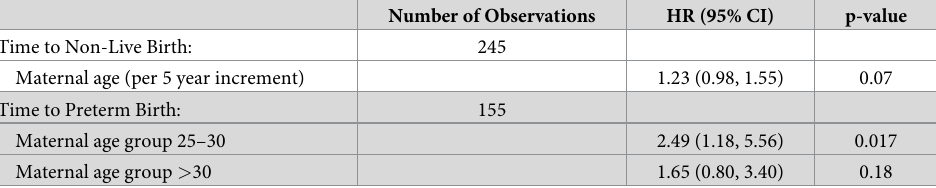
Table 4. Cox proportional hazards models (adjusted for region, parent study, and pre-pregnancy ART